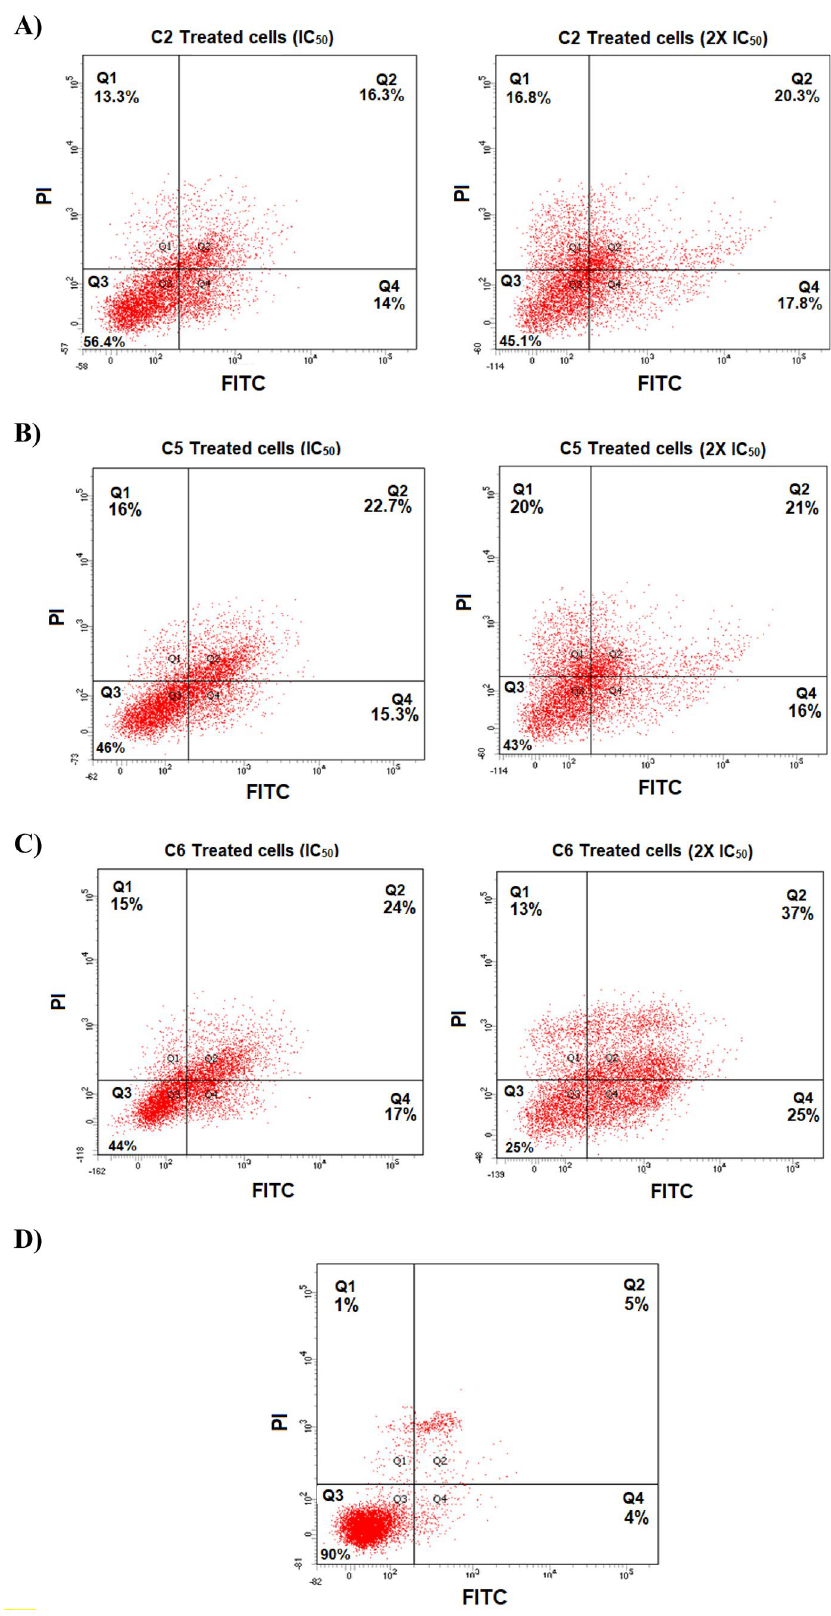
Figure 5. Flow cytometry assay of DU145 cellular death modality. Dot plots of DU145 cells treated with IC 50 and 2X IC 50 of C2 ( A ), C5 ( B ), C6 ( C ) or untreated control ( D ). Q1 indicates necrotic cells, Q2 late apoptotic cells, Q3 viable cells and Q4 early apoptotic